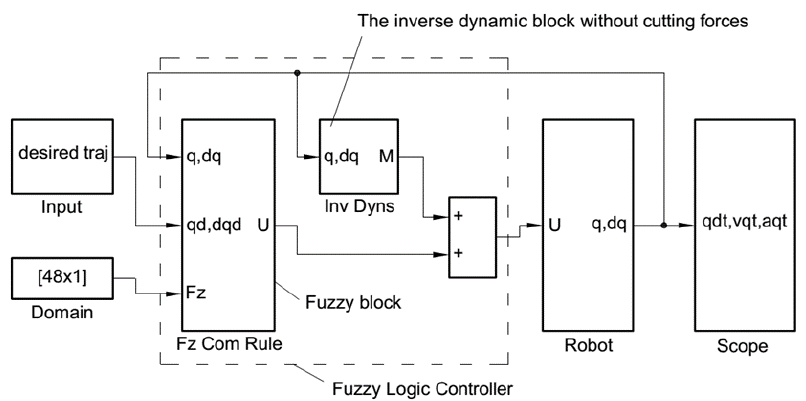
Figure 6. General block diagram of fuzzy control.